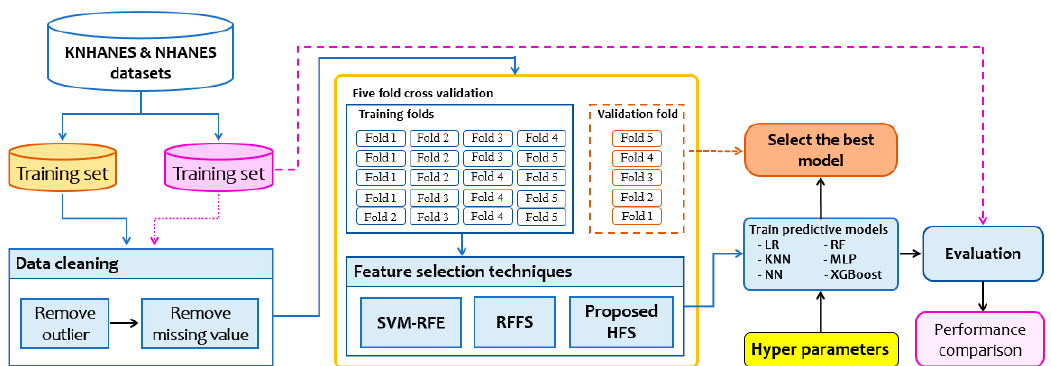
Figure 2. Design of comparative experiments for smoking-induced noncommunicable diseases prediction. K(NHANES): Korean (national health and nutrition examination survey); SVM-RFE: support vector machine recursive feature elimination; RFFS: random forest feature selection; HFS: hybrid feature selection; LR: logistic regression; KNN: k-nearest neighbors; NN: neural network; RF: random forest; MLP: multilayer perceptron; XGBoost: extreme gradient boosting.